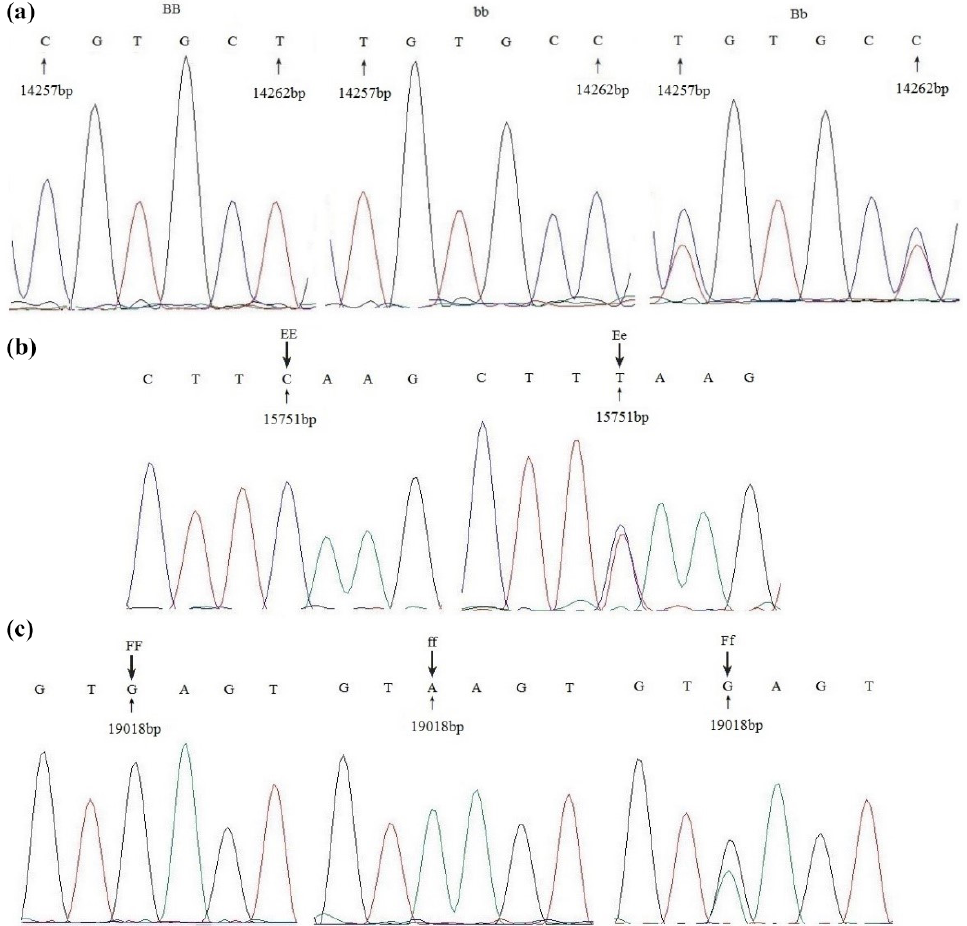
Figure 2. Sequence alignment of three primers with different genotypes in Jinghai Yellow